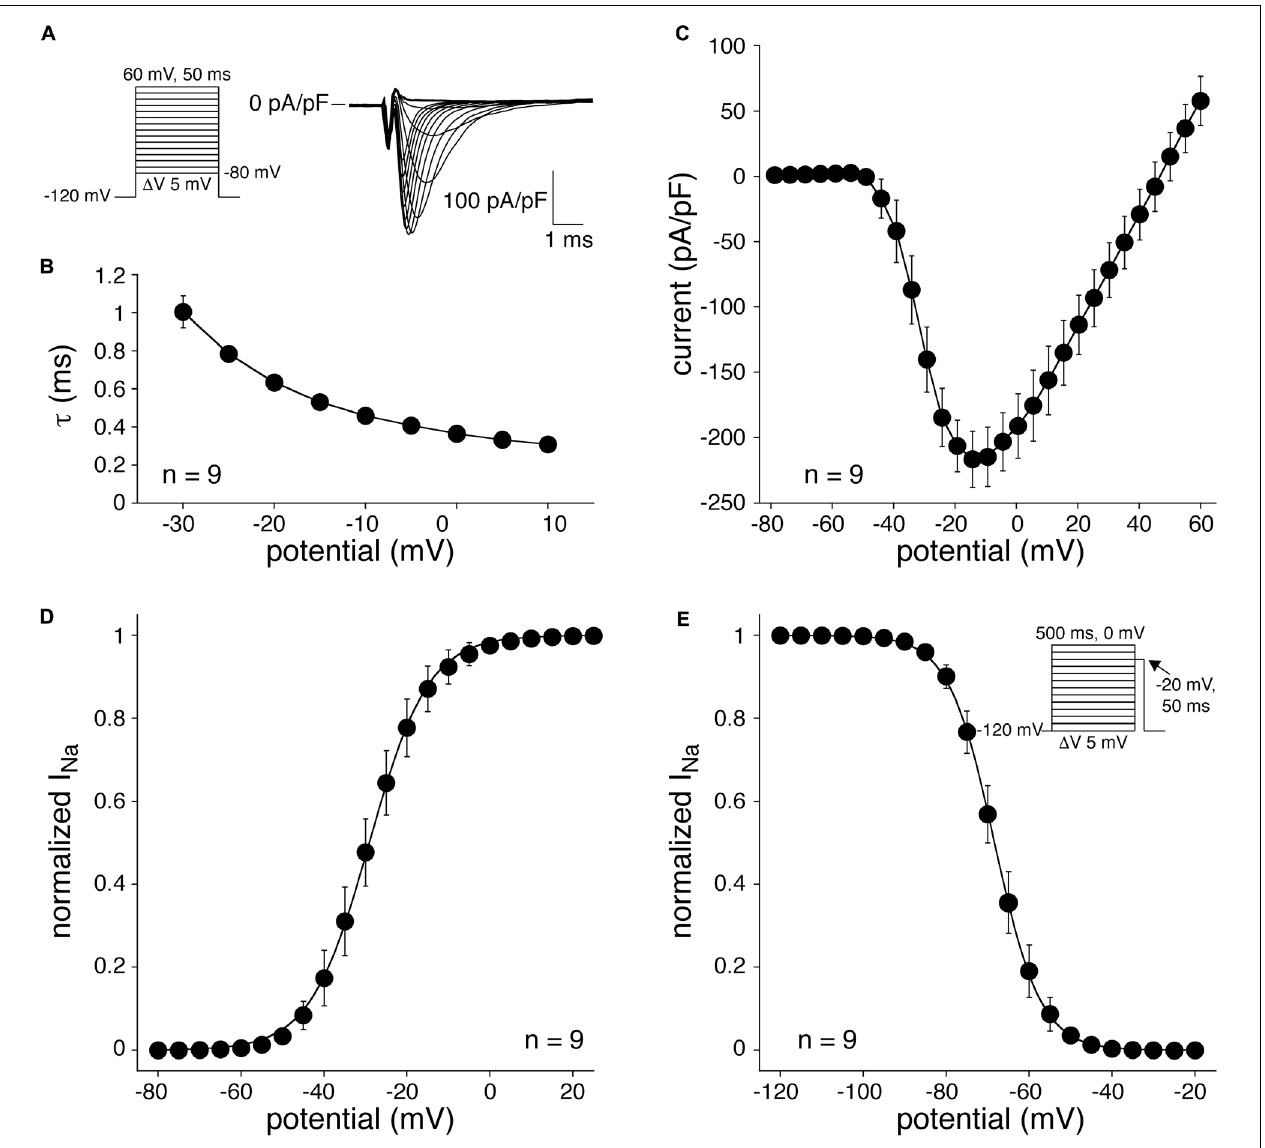
FIGURE 6 | SkM1 current measured at room temperature in single CPCs. (A) Left: voltage clamp protocol used. Right: Typical example of SkM1 current in response to 50-ms depolarizing voltage steps ranging from –50 and +20 mV, from a holding potential of –120 mV. (B) Average time constants of fast and slow SkM1 current inactivation. (C) Average I–V relationship. (D) Average steady-state activation curve. The solid line is the Boltzmann fit to the average data. (E) Average steady-state inactivation curve. The solid line is the Boltzmann fit to the average data. Inset: voltage clamp protocol for determination of